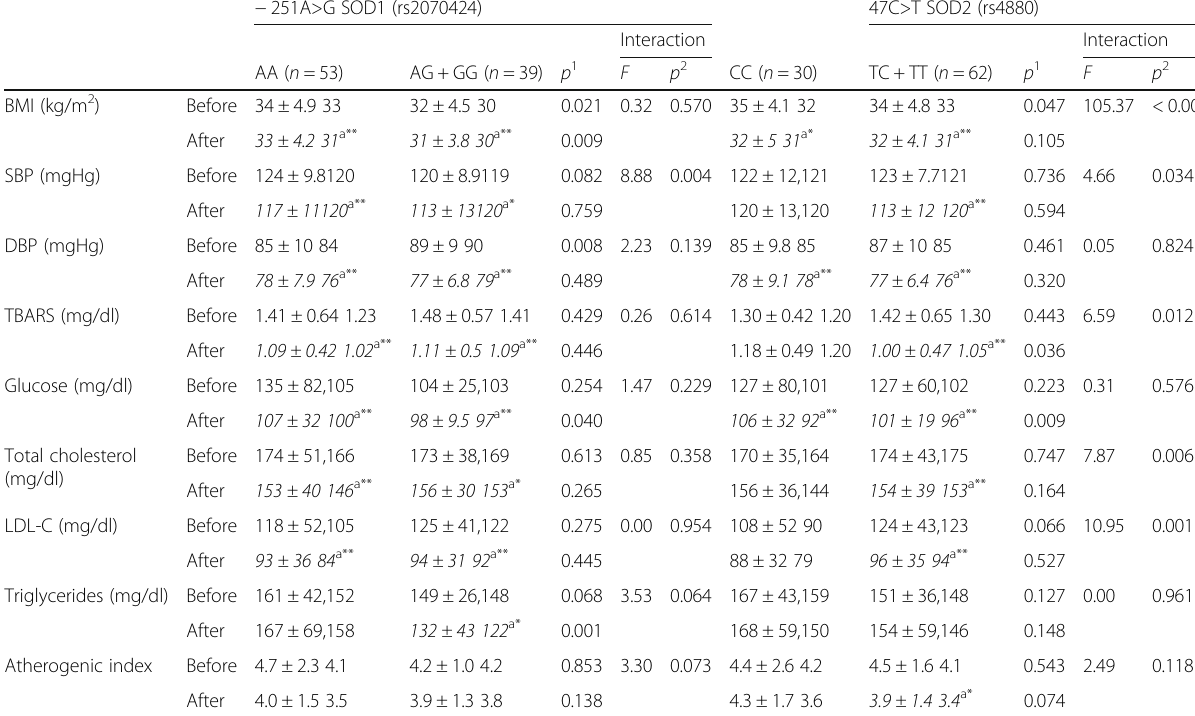
Table 3 Effect of the dietary intervention on participants stratified by − 251 A>G SOD1 (rs2070424) and 47C>T SOD2 (rs4880) polymorphisms, and interaction between period and group − 251A>G SOD1